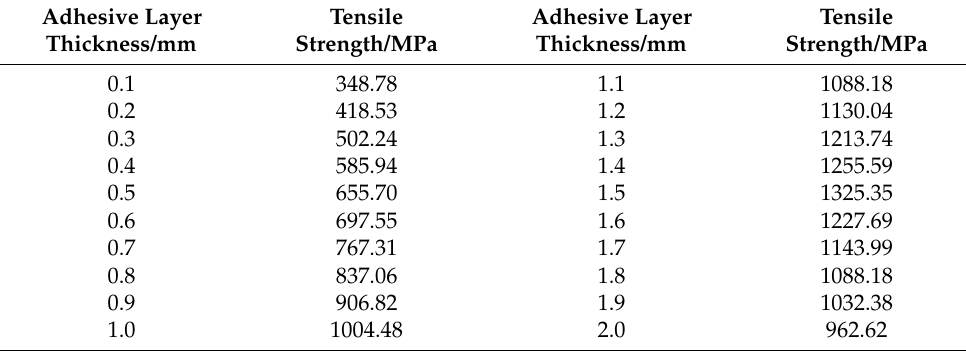
Table 3. Properties of adhesive